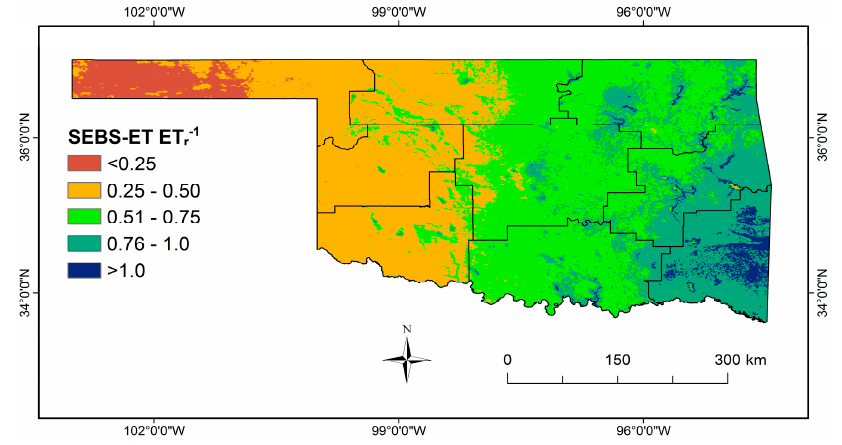
Figure 5. The ratio of average annual SEBS-ET to ET r across Oklahoma during the period 2001–2014. It should be noted that CDs 6 and 9 in southeast have a forested area of more than 29%. Hence, their ET estimates may not be accurate since the flux towers used in validation did not include forest land cover.